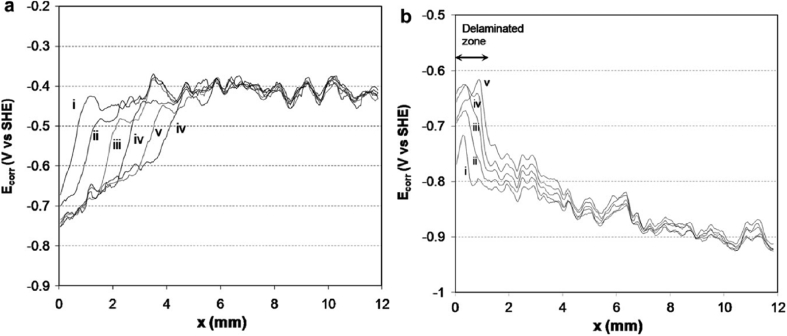
Profiles of Ecorr with distance as a function of time for a hot-dip-galvanised zinc substrate with a polyvinyl butyral (PVB) coating containing: (a) 0.05; (b) 0.3 Zn2+ cross-linked sulphonated polystyrene pigment volume fractions. The curves show the rate of coating delamination away from a coating defect. From Williams et al. [2012].29